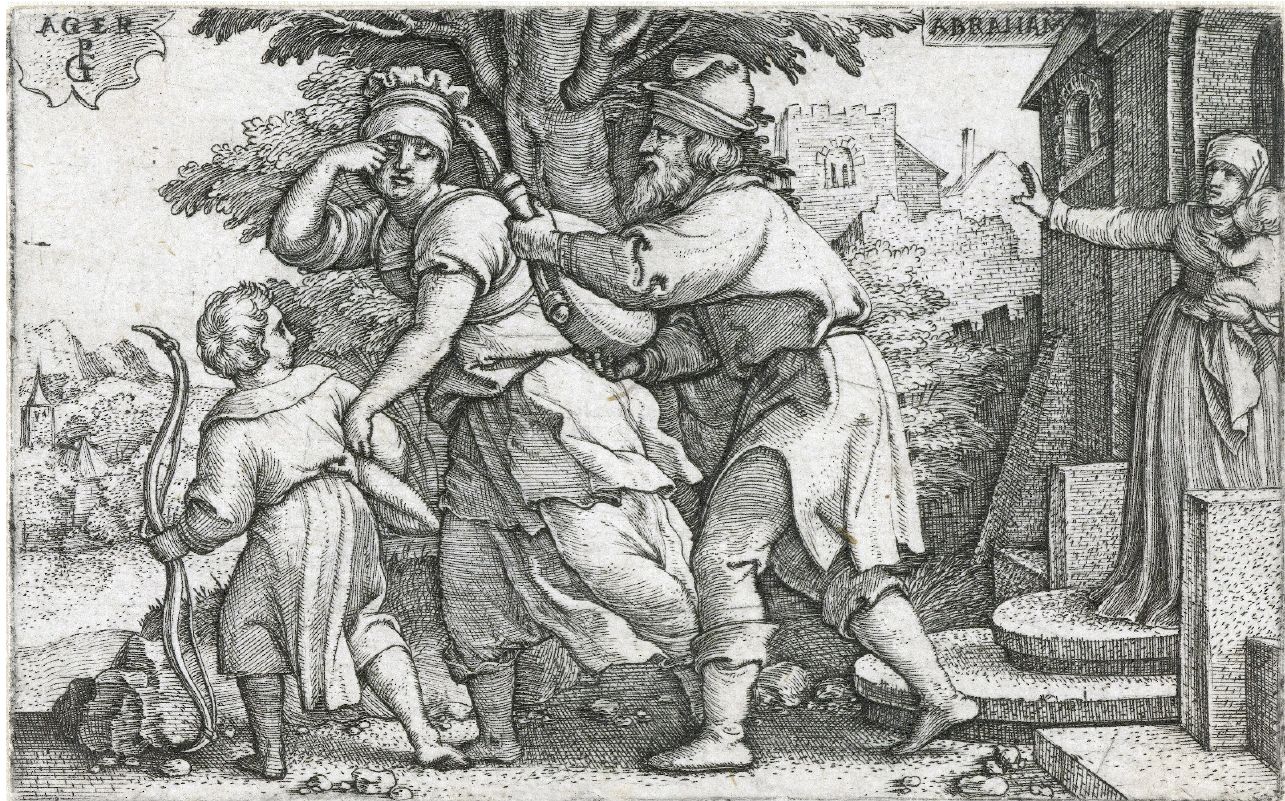
Figure 9. Georg Pencz, 1541–1545. Amsterdam, Rijksmuseum, RP-P-H-Z-64. Dutch artists in the 16th and 17th centuries displayed great sensitivity in expressing